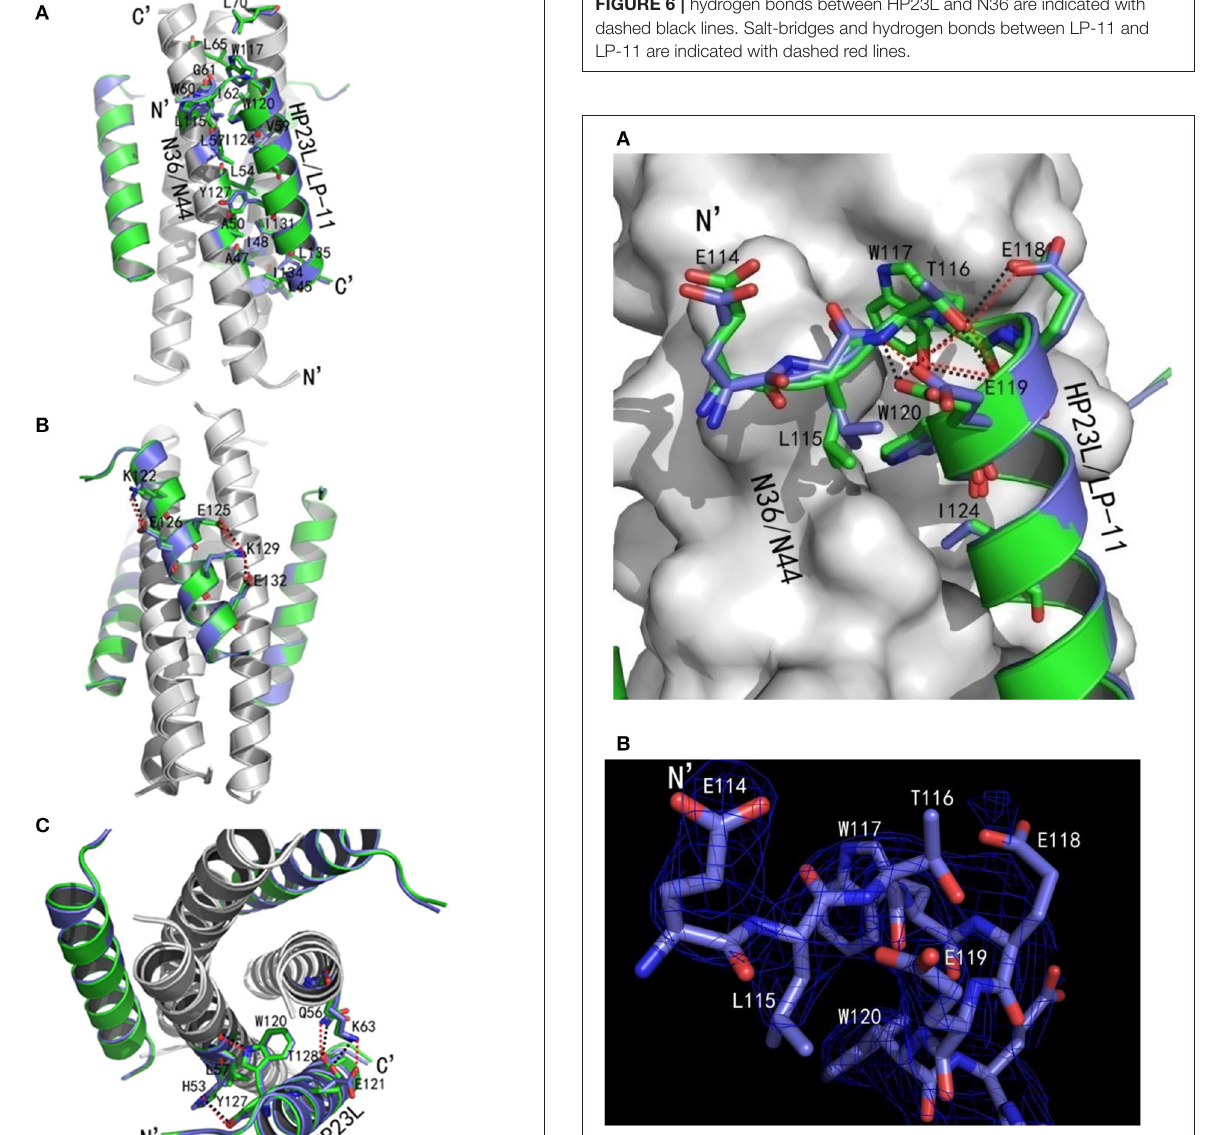
FIGURE 7 | Comparison of the hook regions of HP23L and LP-11 by superimposing. (A) N44 and N36 trimers are shown as surface models in gray. HP23L and LP-11 are respectively shown in green and blue. Residues involving in the hook and pocket-binding domain are shown as stick models with labels. Hydrogen bonds existed in N termini of HP23L and LP-11 are indicated in dashed lines and shown respectively in black and red. (B) The hook region of LP-11 is shown with the final model with the superimposed 2Fo-Fc electron density map (1.5s contour, blue mesh). Stick model is colored with the same scheme used in (A)